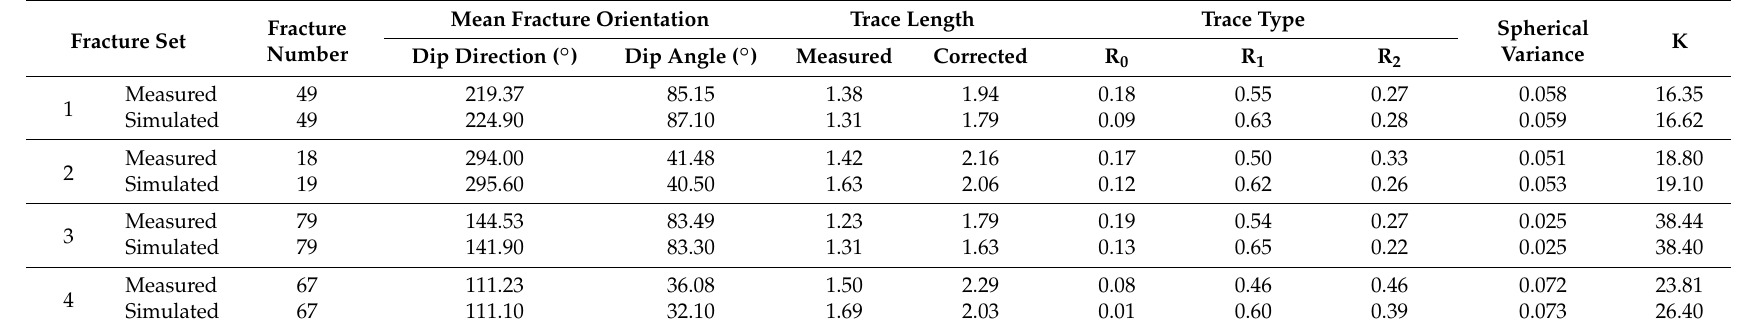
Table 2. Parameter comparison between the measured data and simulated data obtained from the optimal